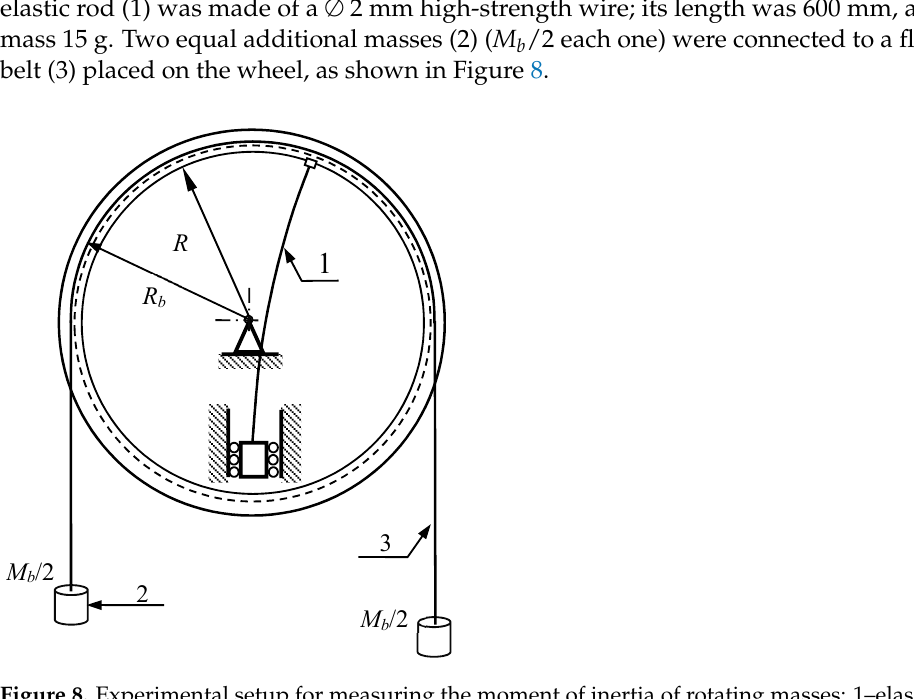
Figure 8. Experimental setup for measuring the moment of inertia of rotating masses: 1–elastic rod, 2–additional masses, 3–flexible